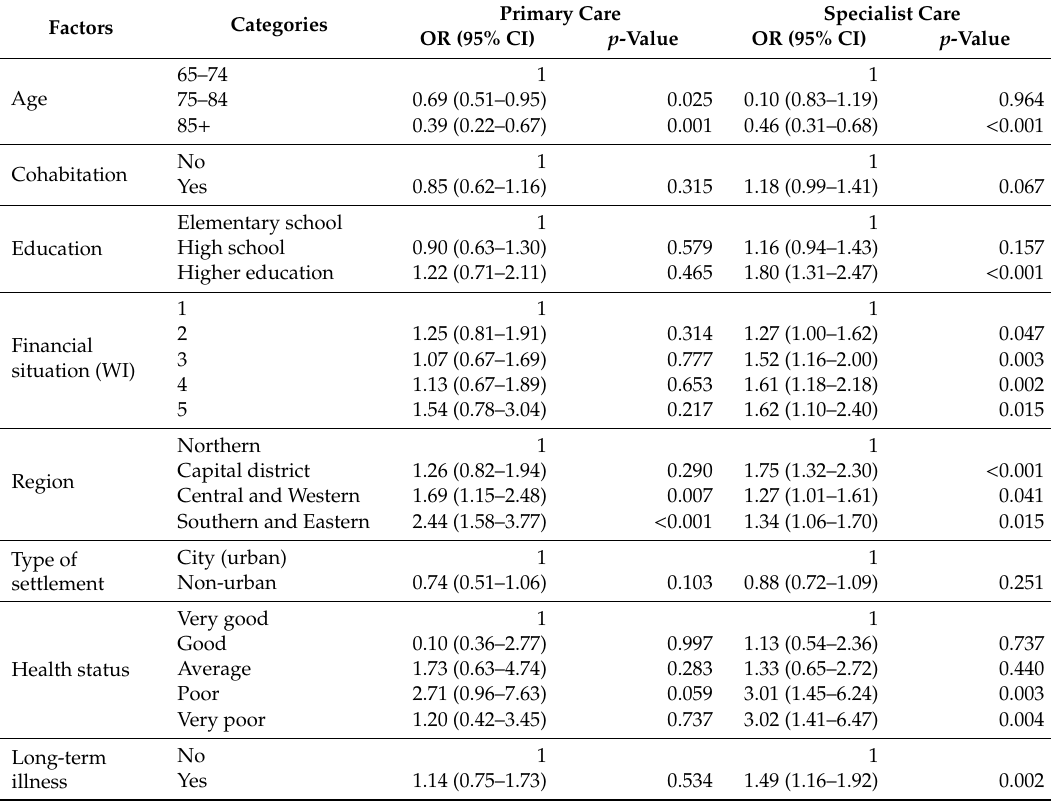
Table 3. Multivariable analysis of the utilization of primary and specialist healthcare services by elderly CVD patients in the Republic of